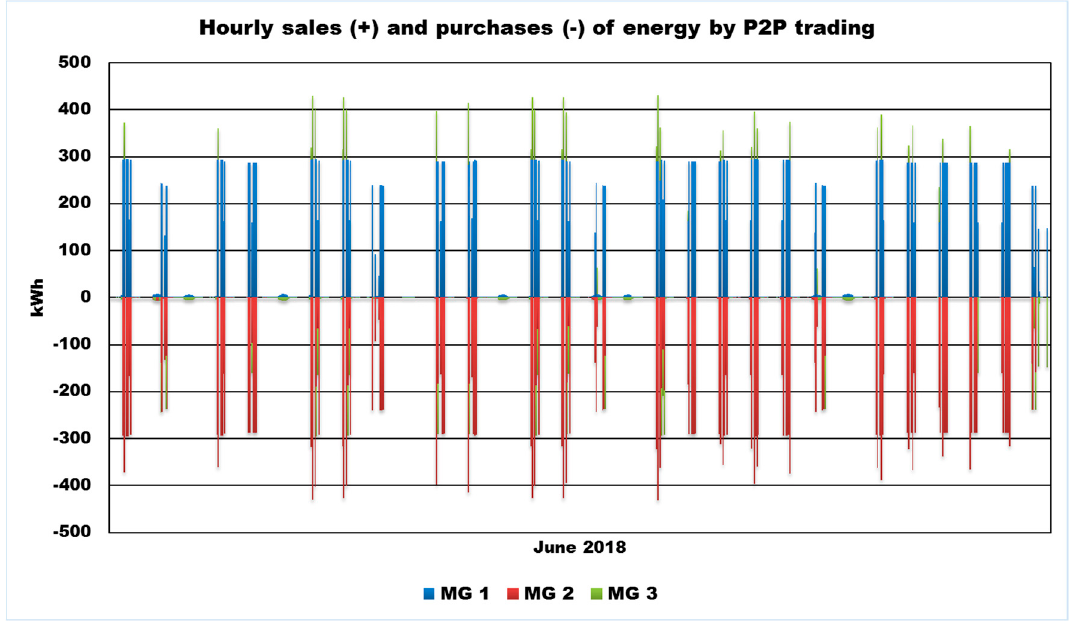
Figure 7. Hourly sales and purchases of energy by P2P trading over the full trading period. Table 1. Simulation results of P2P energy trading in a multi-microgrid example.